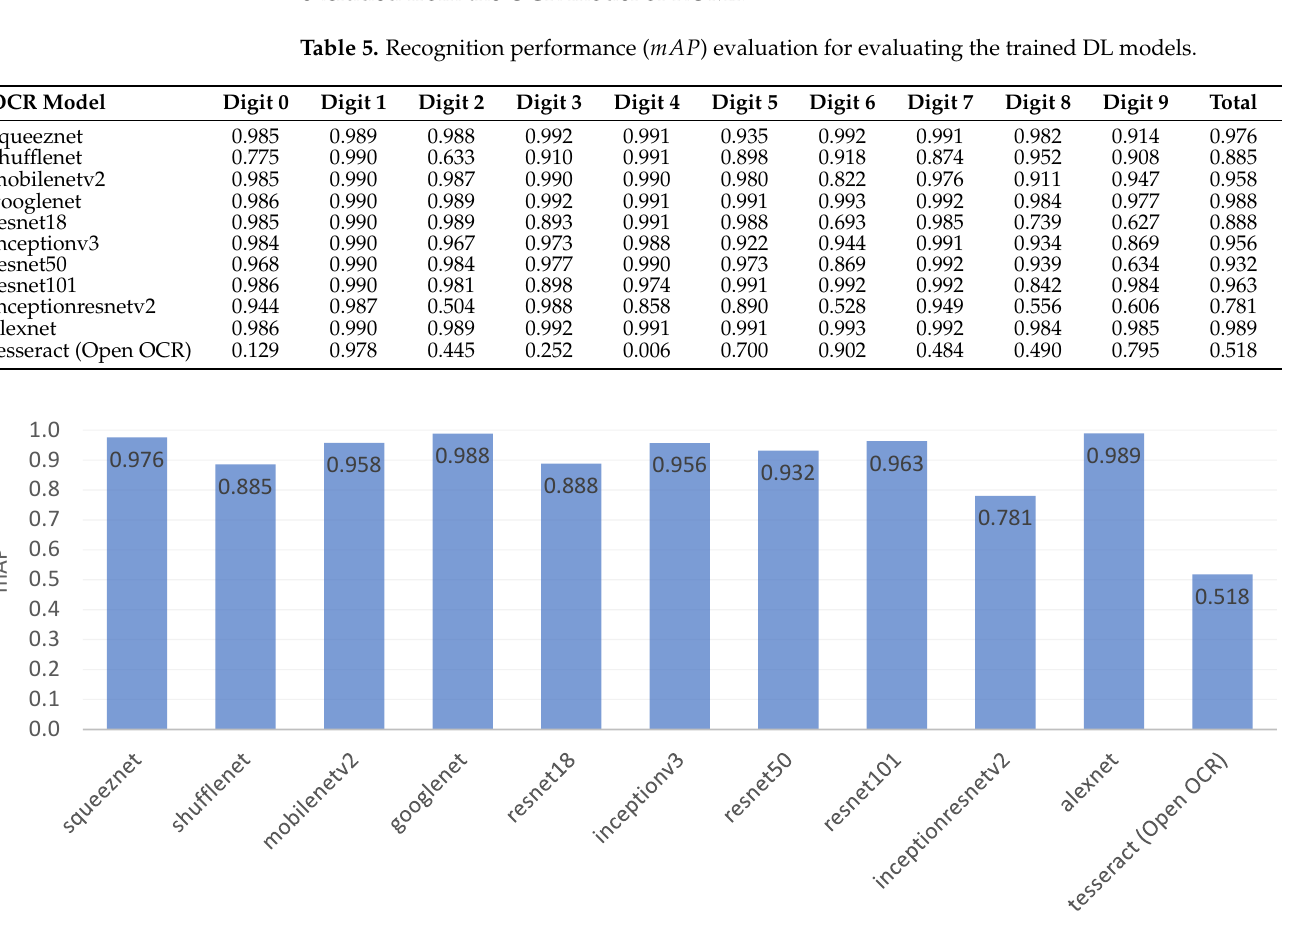
Figure 6. Recognition performance evaluation results for the trained DL